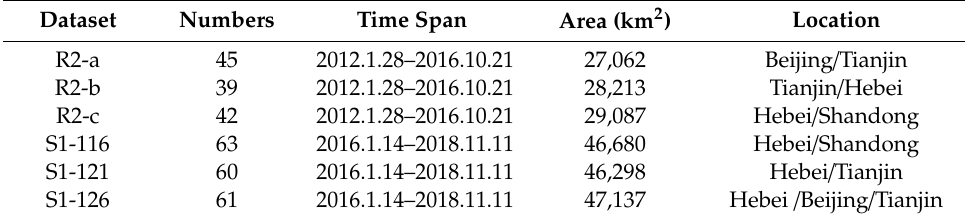
Table 1. Information of the Radarsat-2 and Sentinel-1 images. R2 and S1 are the abbreviations of Radarsat-2 and Sentinel-1, respectively. The numbers in S1 are the frame numbers of the master image. “Numbers” indicates the numbers of SAR